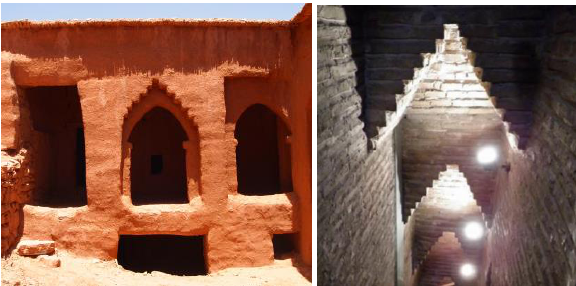
Figure 10. Corbel vaults of in Ait Ben Haddou (Morocco) and the Torre del Salvador (Teruel).